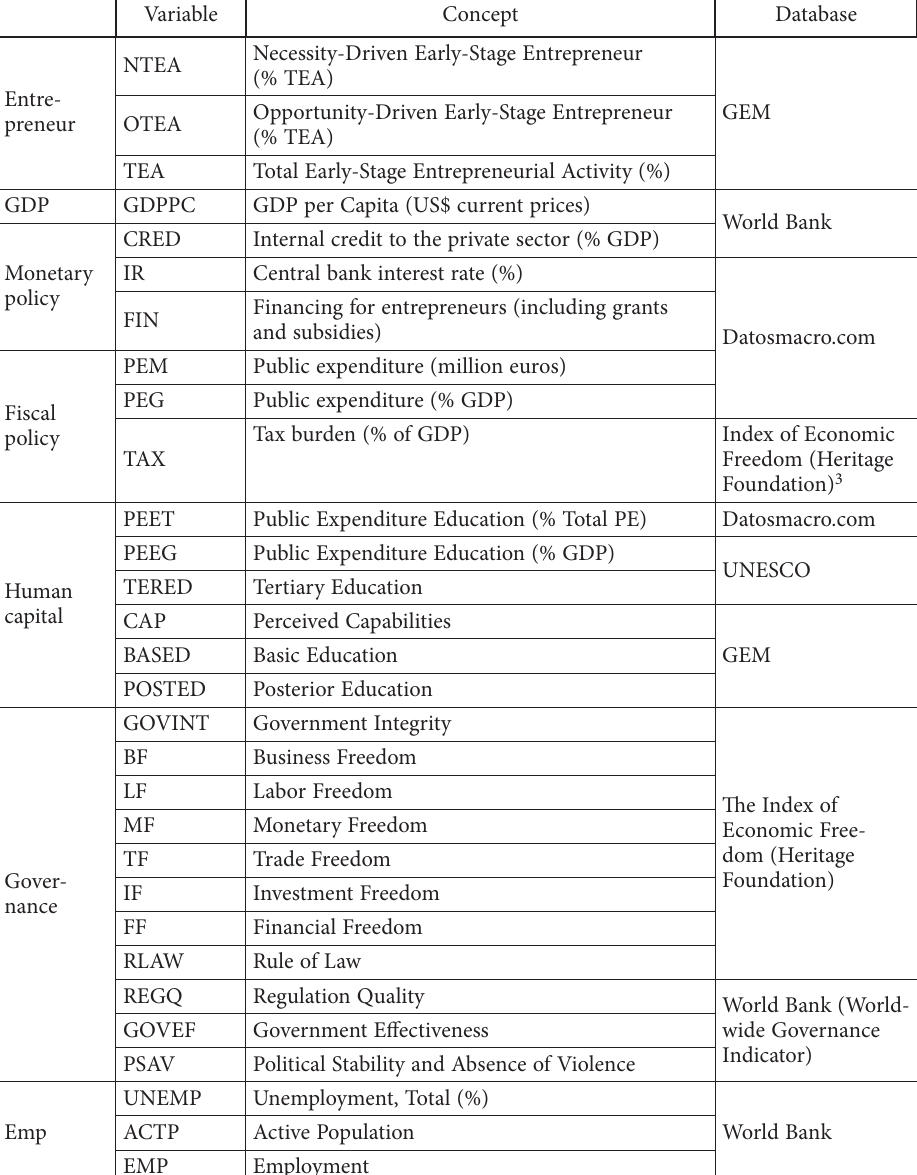
Table 2. Proxy variables (initial) for the socioeconomic factors affecting TEA Variable